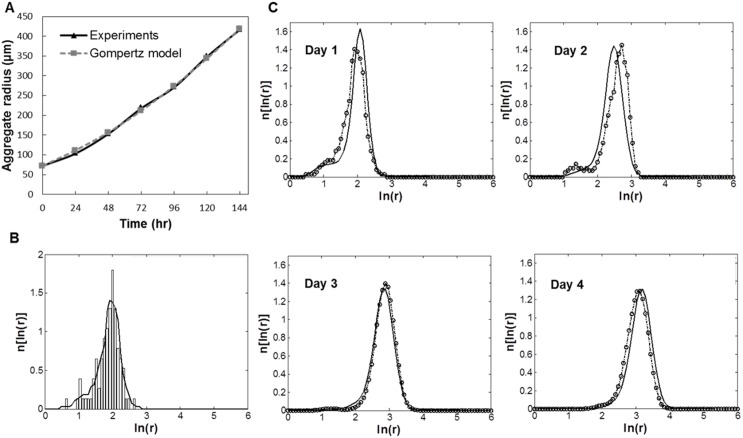
PBE model for the ESC aggregate culture in spinner flasks.(A) Mouse ESC aggregates in dishes were monitored and their size was measured over several days. The experimental data for aggregate growth due to mESC proliferation were compared with the Gompertz model. Relevant parameters were determined: M = 9.71×106, αG = 5.72×10−3 hr−1. (B) Representative data of size (radius) distribution for mESC aggregates cultured at 60 rpm (day 1). Histogram and a continuous distribution curve are shown. (C) Model size distributions (lines) shown for a 96-hour culture at 60 rpm. The original distributions (dash-circle lines) for each time point are shown for comparison.